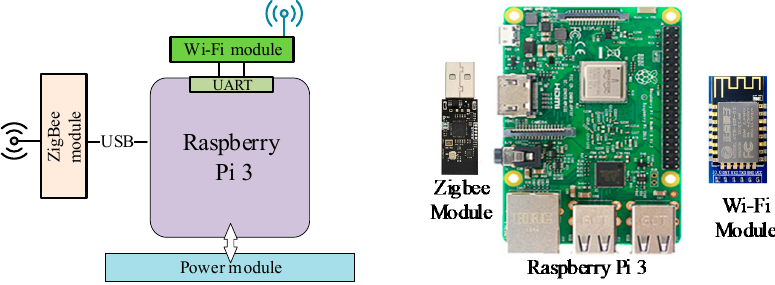
Figure 4. The structure and physical image of the edge computing node.